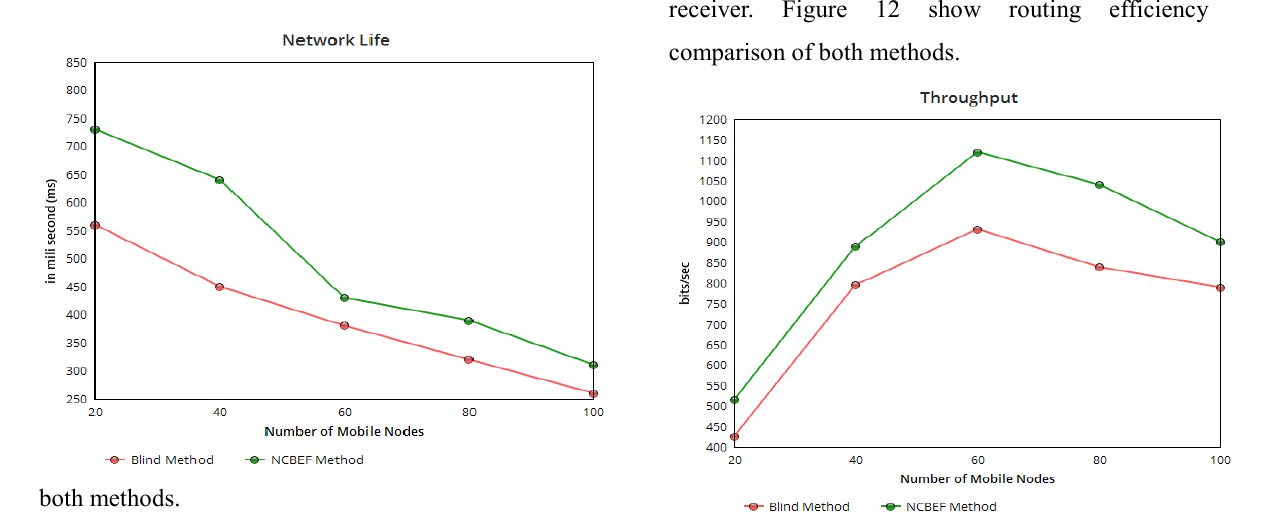
Figure 10. Comparative network life